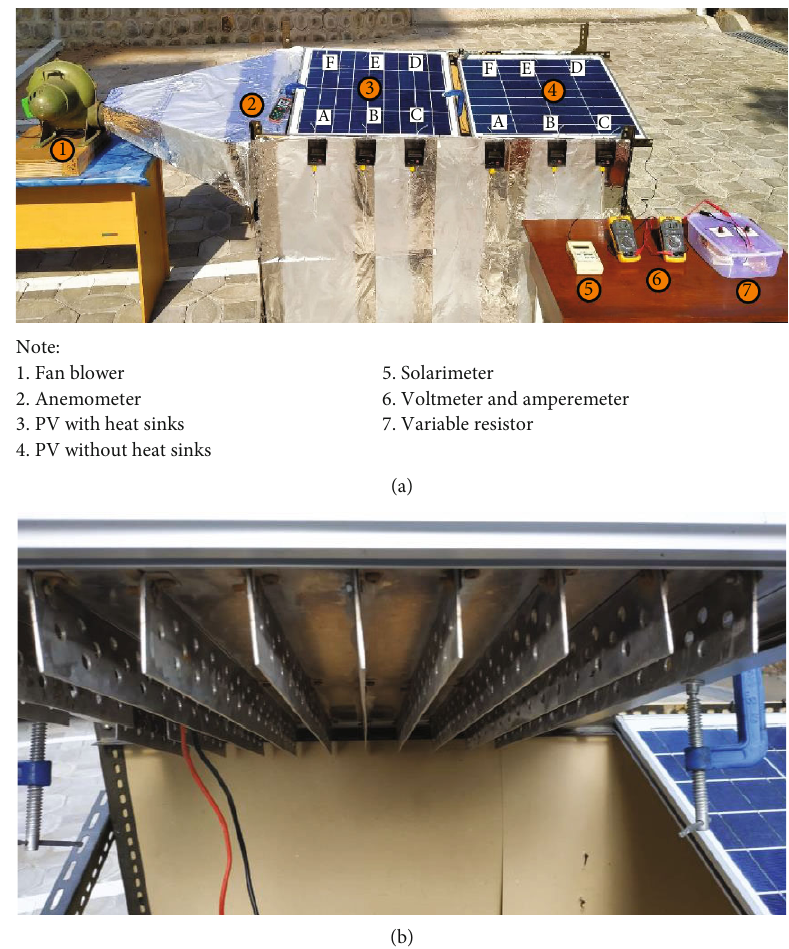
Figure 3: (a) Photograph of the experimental procedure and (b) heat sink con fi guration on the back of the PV